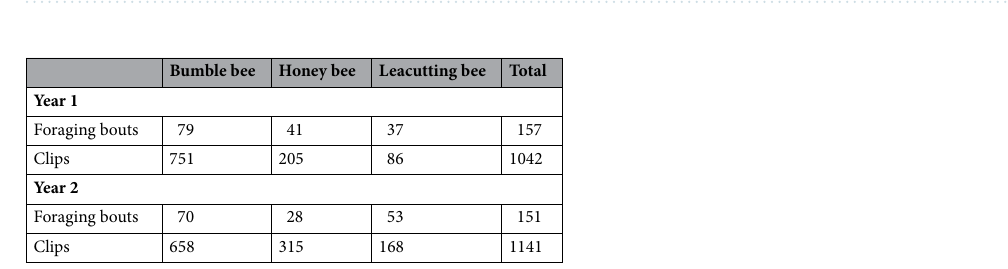
Table 1. The four models of bee movement.